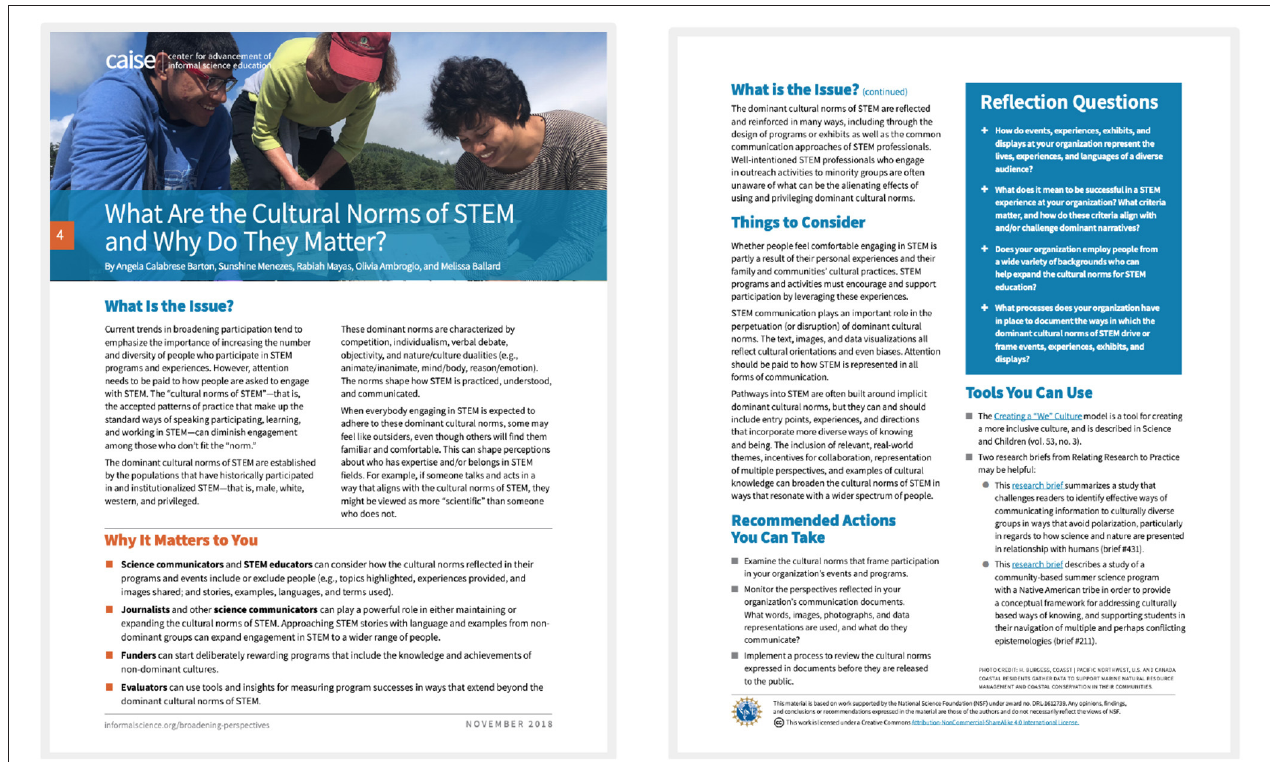
FIGURE 1 | Sample practice brief on cultural norms of STEM. © Center for the Advancement of Informal Science